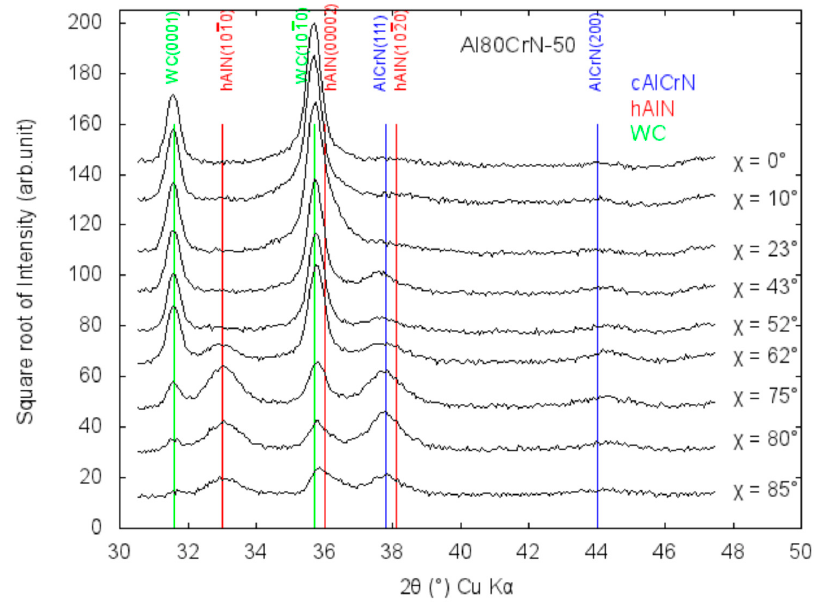
Figure 6. XRD scans of sample Al80CrN–050 with variation of X angle (side inclination), vertical lines indicate reference peak positions as in Figure 2.